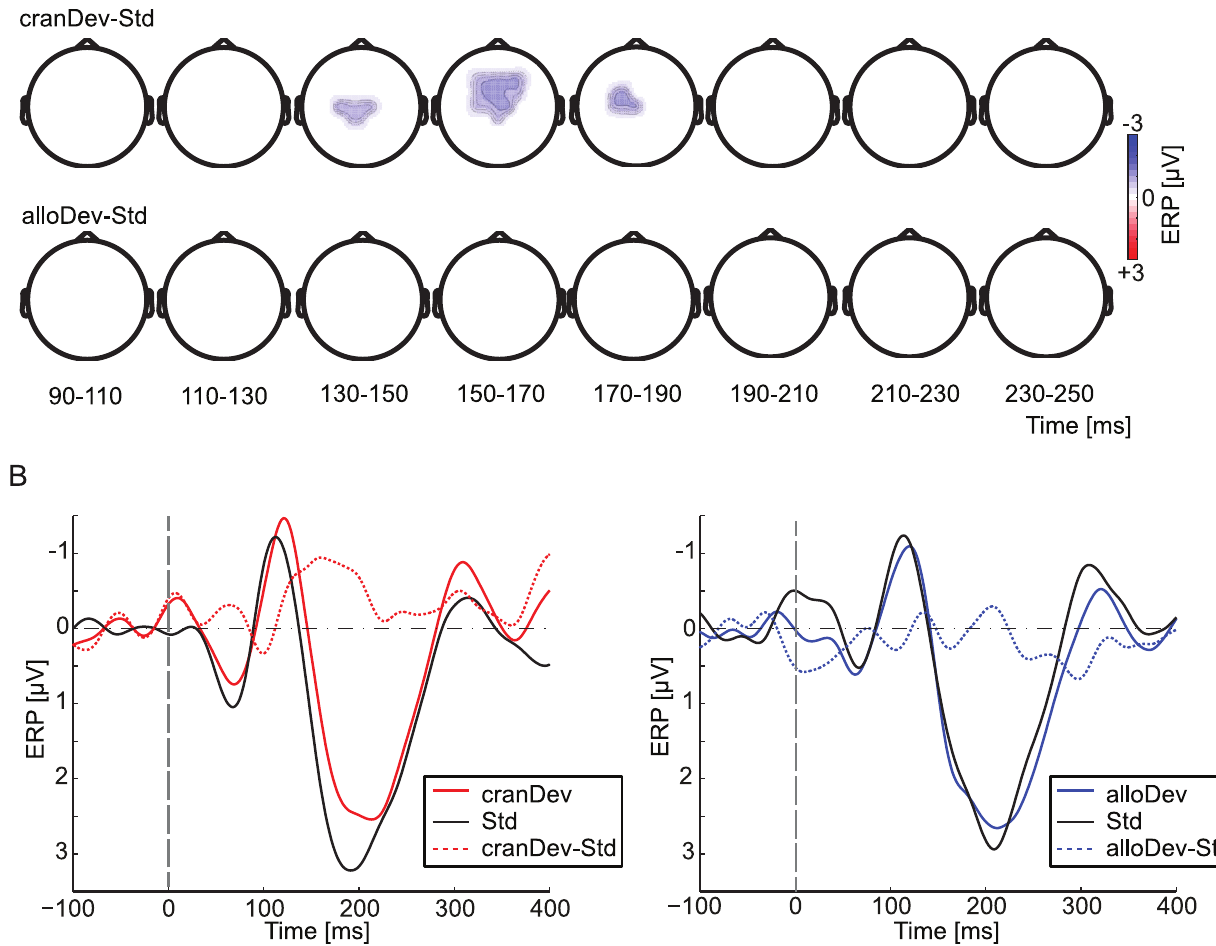
Figure 2. Event-related potentials. (A) Statistical comparisons of craniocentric deviant versus standard and the allocentric deviant versus standard with a nonparametric cluster–randomization approach (two-tailed t -test, corrected for multiple comparisons at a cluster-level). Only difference data from electrodes are shown that were part of a significant cluster ( p , 0.05, cluster level) within the indicated period. The upper row shows significant differences between the craniocentric deviant (cranDev) and the standard (Std), and the lower row differences between the allocentric deviant (alloDev) and the standard. (B) ERP waveforms at fronto-central electrodes for the craniocentric (cranDev, left column) and allocentric deviants (alloDev, right column), and for standards (Std). Solid colored lines indicate ERPs for the deviant (red: craniocentric; blue: allocentric), black lines the standard, and dashed colored lines the difference waves between craniocentric (red) or allocentric (blue) deviants and standards. The vertical dashed gray lines indicate stimulus